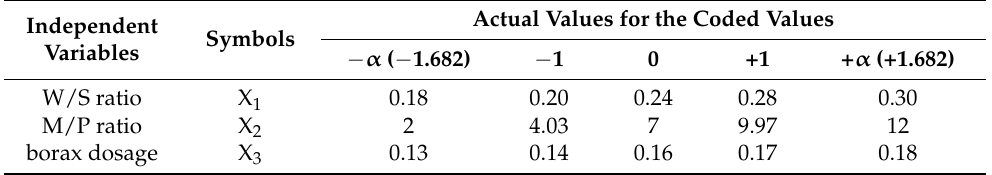
Table 1. Actual values for the variables used in the experimental design.